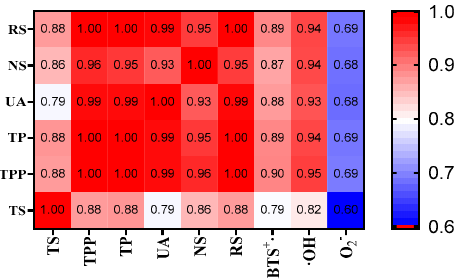
Figure 9. Heat map analysis of the correlation between chemical composition and antioxidative activity. Abbreviations: NS: neutral sugar, UA: uronic acid, RS: reducing sugar, TP: tea protein, TPP: tea polyphenol, TS: total selenium, OH: Hydroxyl radical capacity, O − : superoxide radical capacity, ABTS + : ABTS radical capacity, and T − AOC: total antioxidant capacity. The data in the figure represent the Pearson correlation coefficient.